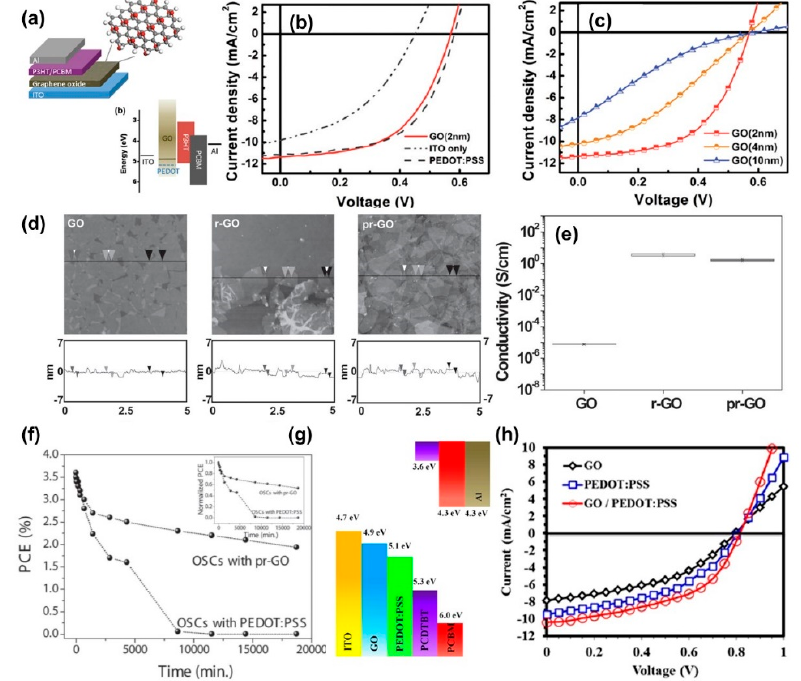
Figure 6. ( a ) Schematic and band diagram of a PSC device consisting of ITO/GO/P3HT: PCBM/Al. ( b ) Current–voltage characteristics of photovoltaic devices with no hole transport layer (curve labeled as ITO), with a 30-nm PEDOT: PSS layer and a 2-nm thick GO film. ( c ) Current–voltage characteristics of ITO/GO/P3HT: PCBM/Al devices with different GO thickness. All measurements were under simulated A.M. 1.5 illumination at 100 mW/cm 2 . Reproduced with permission [83] . ( d ) AFM images and ( e ) conductivity of spin-coated GO-film, r-GO film, and pr-GO film. Reproduced with permission [90] . ( f , g ) Schematic diagram and structure of PSCs using a GO/PEDOT: PSS double hole transport layer. ( h ) I–V curves of PSCs using GO, PEDOT: PSS, and GO/PEDOT: PSS as hole transport layers. Reproduced with permission [93] .